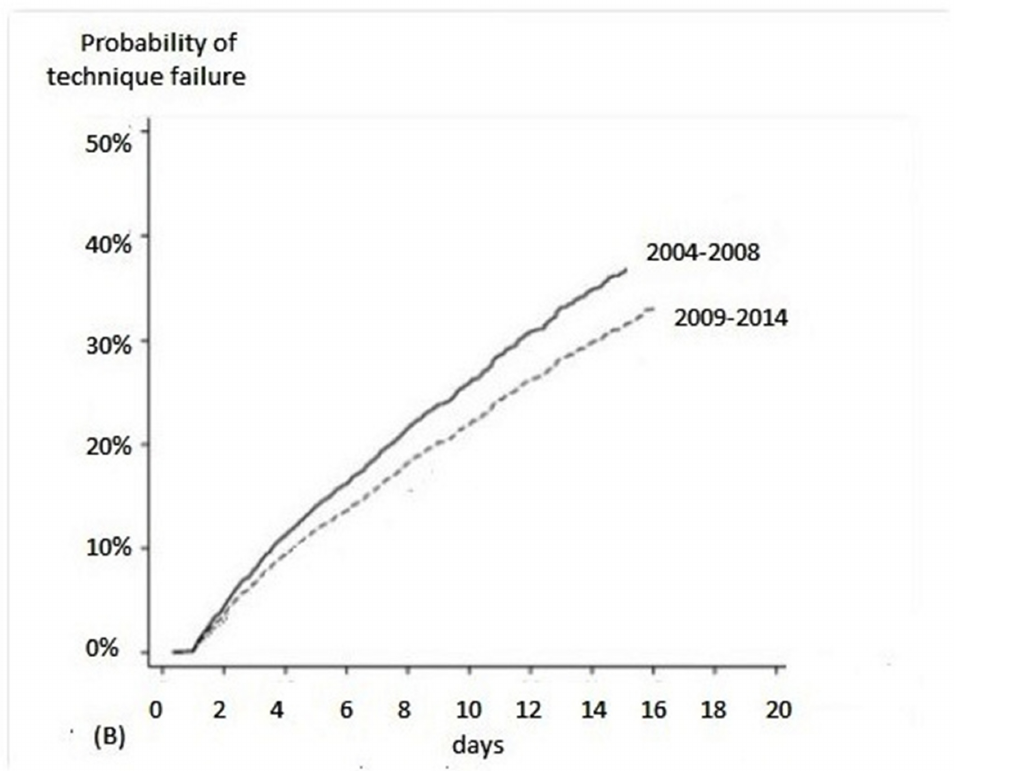
Fig 3. Probability of technique failure according to time period.